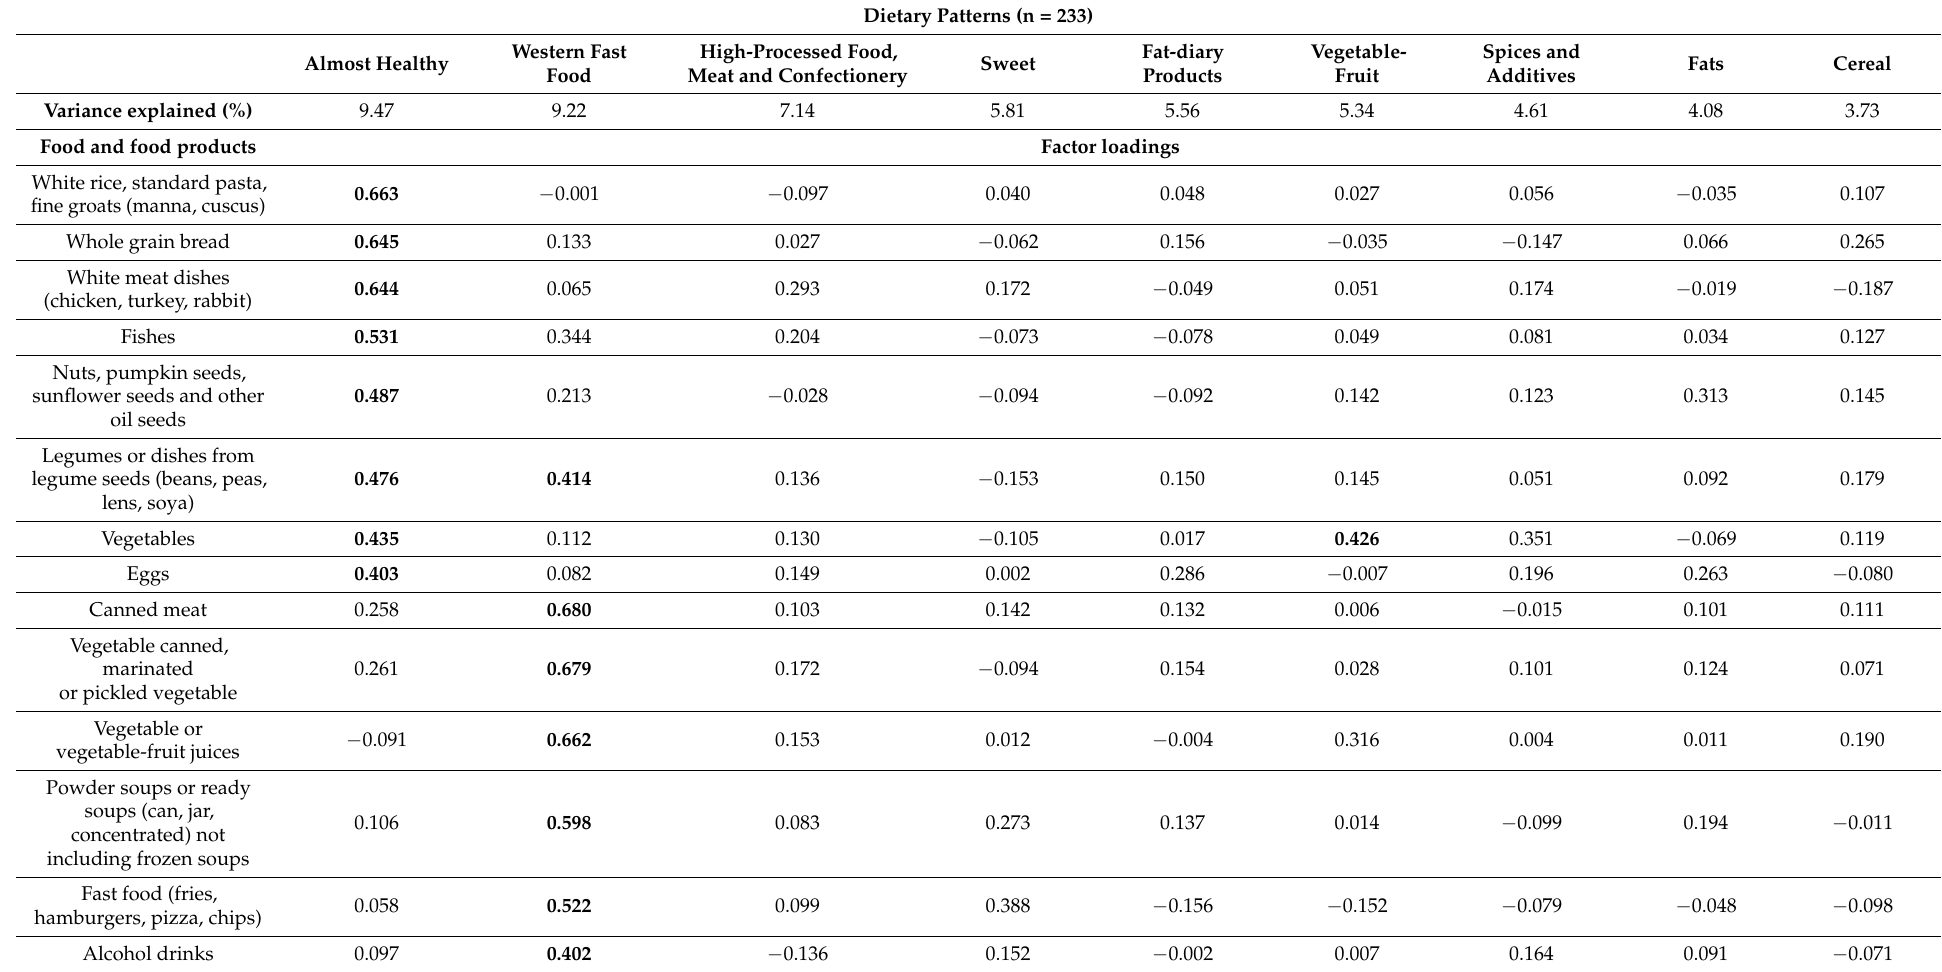
Table 3. Factor loading matrix for the nine major dietary patterns identified from the Food Frequency Questionnaire (FFQ). Dietary Patterns (n =